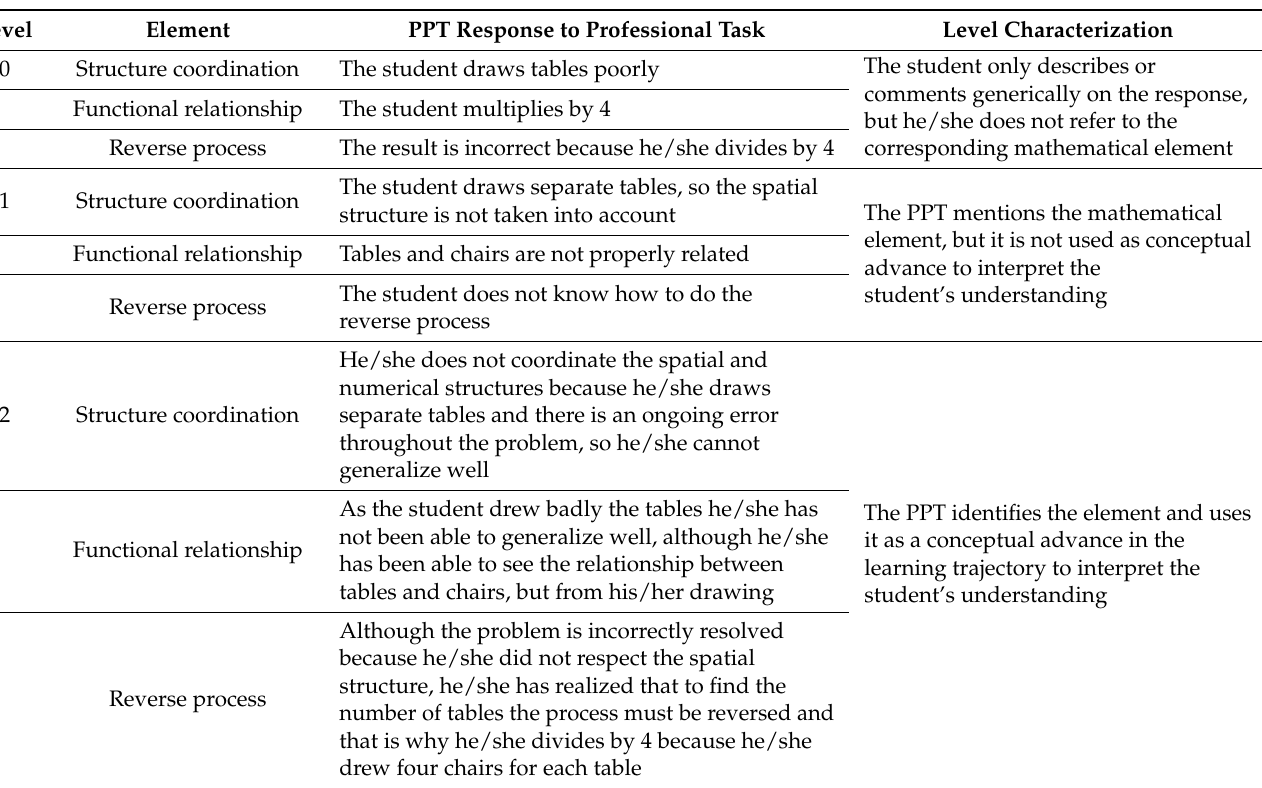
Table 4. Examples of level